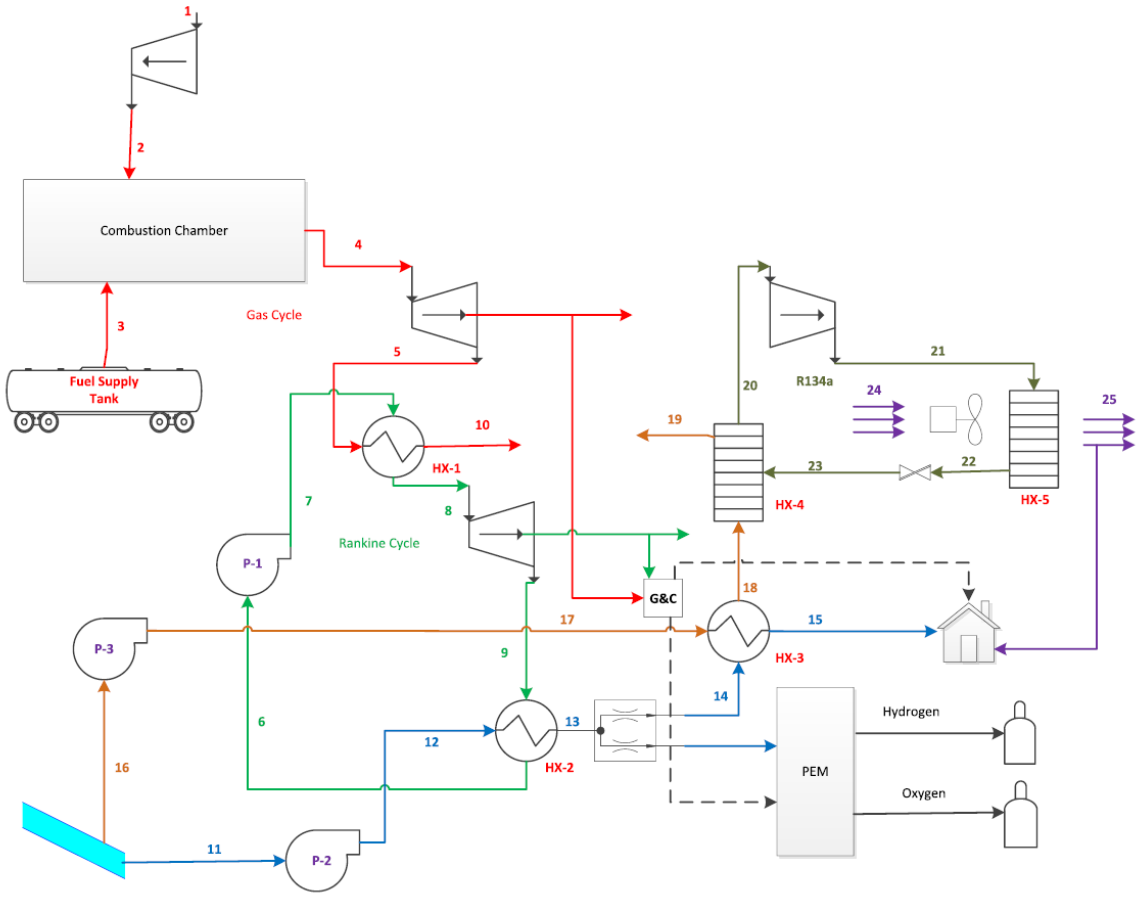
Figure 5. Polygeneration system for hydrogen generation unit for residential scale [63].